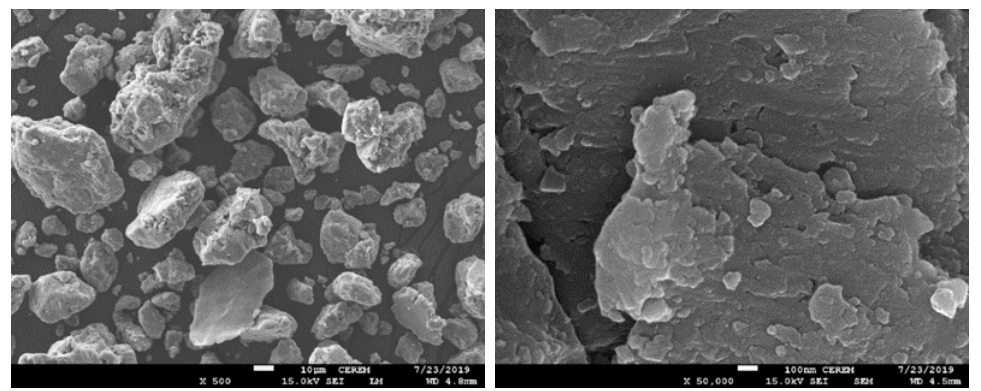
Figure 8. FESEM images for LHHSBM-Al powder.